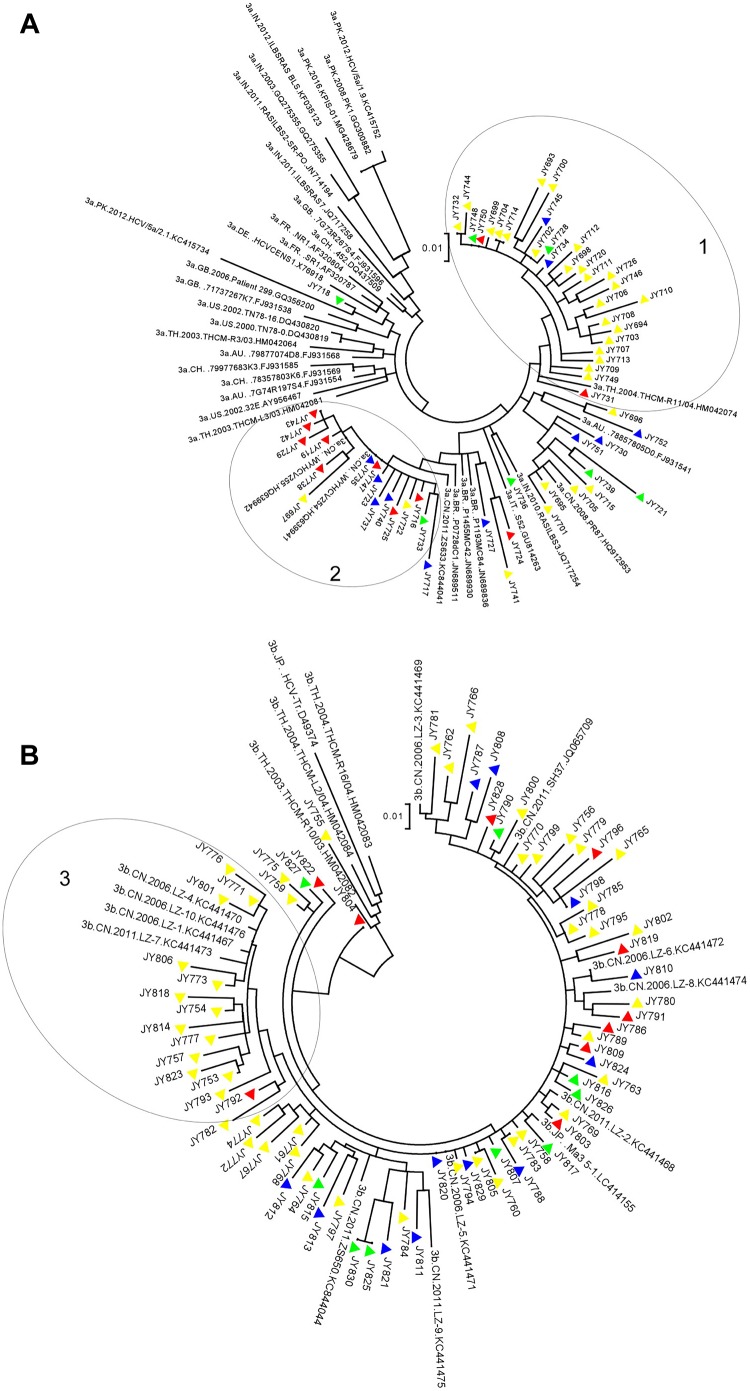
Maximum likelihood trees constructed for GT3a and GT3b NS5A sequences. The vertical scale bar represents 0.01 nucleotide substitutions per site. The triangular symbols provided next to the isolate names denote their respective collection regions: red indicates Southern China-origin, blue indicates Western China-origin, yellow indicates Eastern China-origin, and green indicates Northern China-origin, respectively. The geographic codes are: AU = Australia, BR = Brazil, CH = Switzerland, CN = China, DE = Germany, FR = France, GB = United Kingdom, JP = Japan, IN = India, IT = Italy, PK = Pakistan, TH = Thailand, US = United States. Three circles indicate cluster 1, 2 and 3. (A) The tree was constructed using 60 GT3a NS5A nucleotide sequences determined from this study and 35 reference sequences from China (HQ912953, KC844041, HQ639941, HQ639942), India (GQ275355, JN714194, JQ717254, JQ717258, KF035123), Pakistan (GQ300882, KC415734, MG428679, KC415752), Thailand (HM042064, HM042074, HM042081), United States (AY956467, DQ430819, DQ430820), Australia (FJ931541, FJ931554, FJ931568), Brazil (JN689511, JN689836, JN689930), France (AF320787, AF320804), Germany (X76918), Italy (GU814263), Switzerland (DQ437509, FJ931569, FJ931585) and United Kingdom (FJ931538, FJ931596, GQ356200). The tree with the highest log likelihood (–2420.88) was shown. There were a total of 263 positions in the final dataset. (B) The tree was constructed using 78 GT3b NS5A nucleotide sequences determined from this study and 17 reference sequences from China (JQ065709, KC441467–KC441476, KC844044), Japan (D49374, LC414155), and Thailand (HM042082, HM042083, HM042084). The tree with the highest log likelihood (–2437.25) was shown. There were a total of 267 positions in the final dataset.